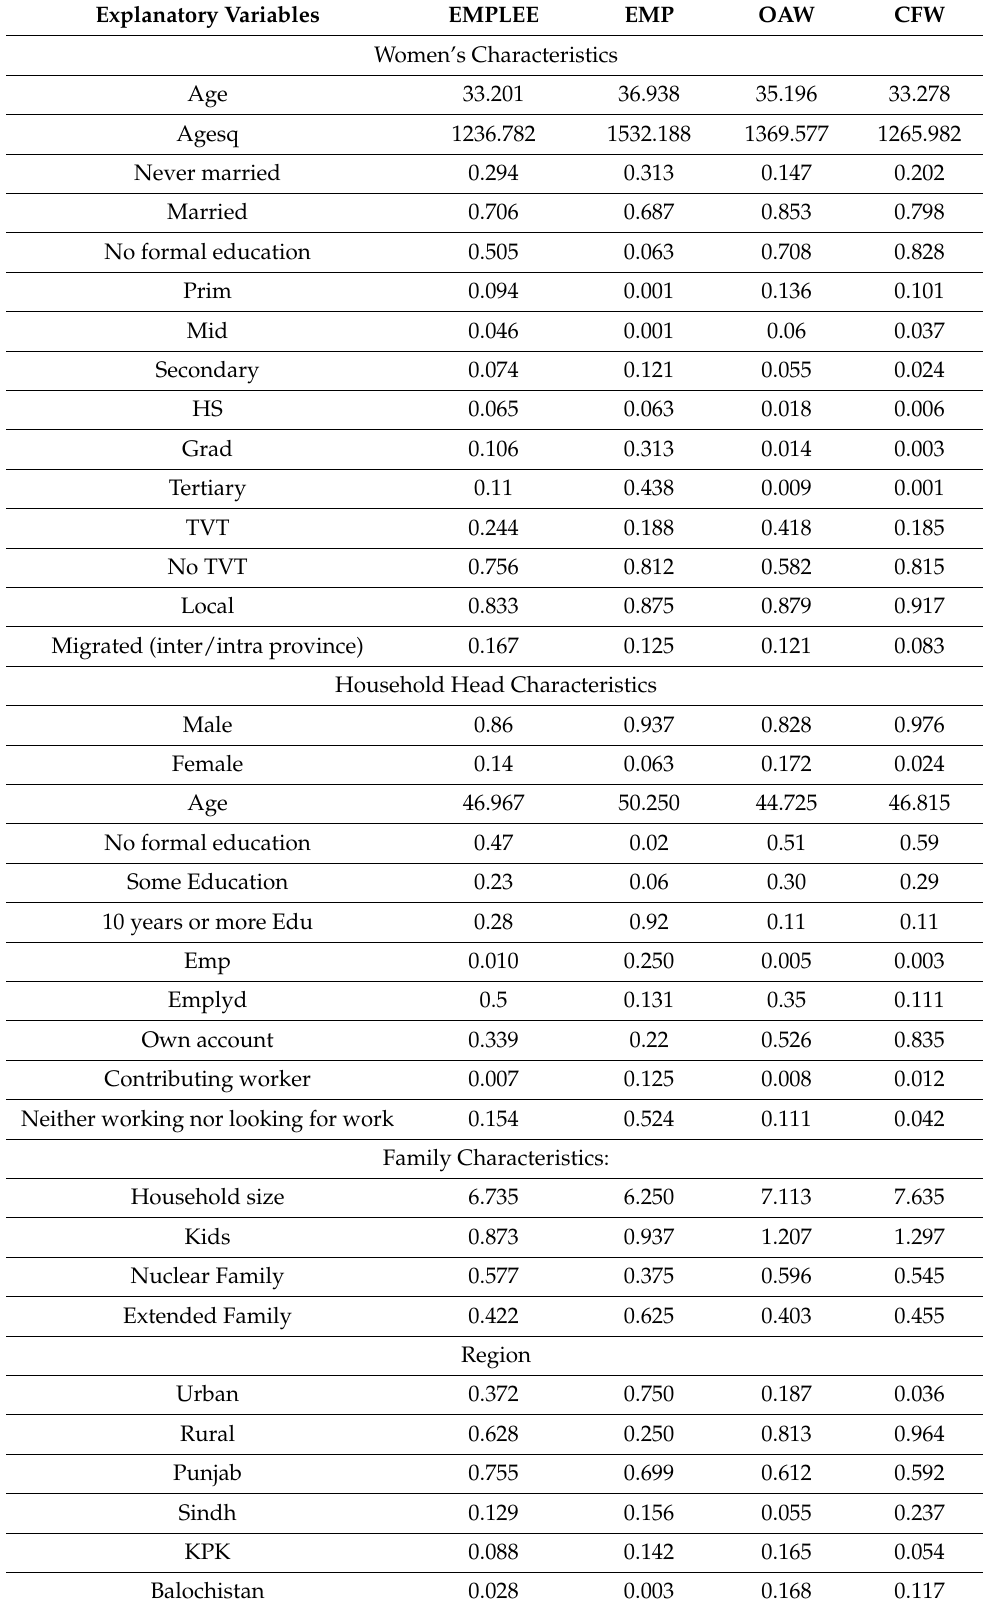
Table 2. Summary statistics of